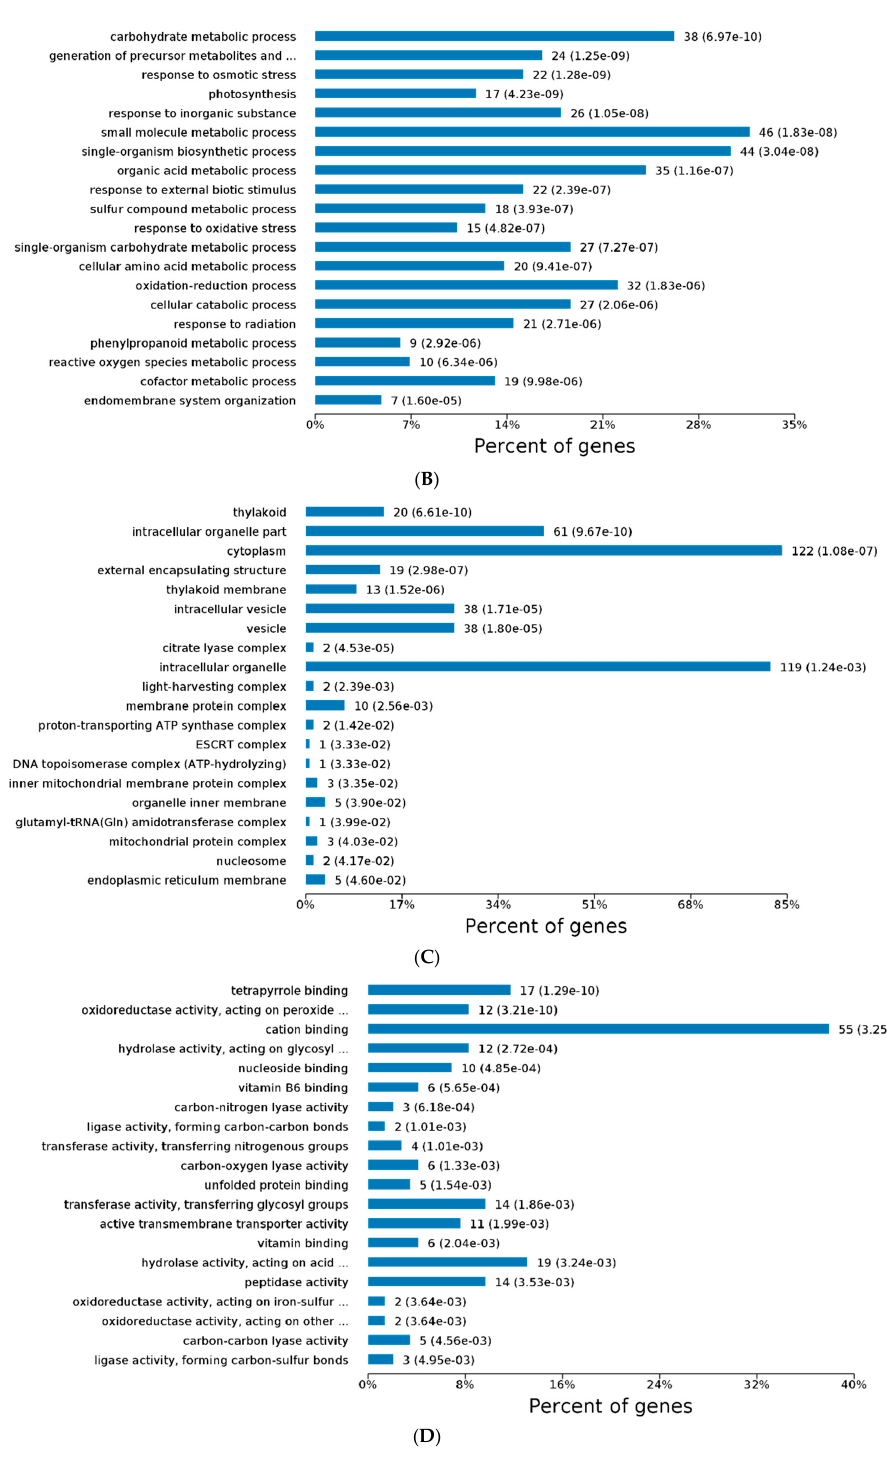
Figure 2. Gene ontology (GO) analysis results for significant protein enrichment between the B. pervariabilis × D. grandis induced by AP-toxin and the control group. ( A ) The top 10 most significant enriched entries in the three categories biological processes (BP), cell component (CC), and molecular function (MF). The p value is set to 0.05, and the items in the same category are sorted by the p value. The left y -axis represents the percentage, and the right y -axis represents the number of genes / proteins enriched under a certain category. ( B ) The results for the biological processes that are significantly enriched, ( C ) the results for the significantly enriched cellular components, and ( D ) the results for the molecular functions that are significantly enriched. In ( B , D ), the horizontal axis indicates the percentage of genes / proteins enriched in each case, and each bar is followed by the number of proteins and the corresponding p